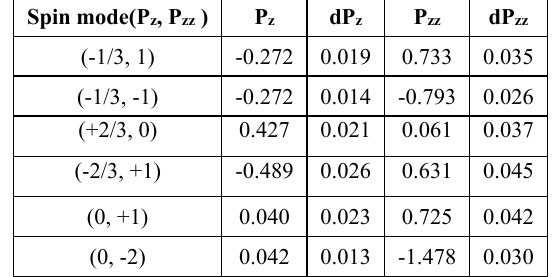
Table 1. The vector and tensor polarization for different spin modes of SPI Spin mode(P z , P zz ) P z dP z P zz dP zz (-1/3, 1) -0.272 0.019 0.733 0.035 (-1/3, -1) -0.272 0.014